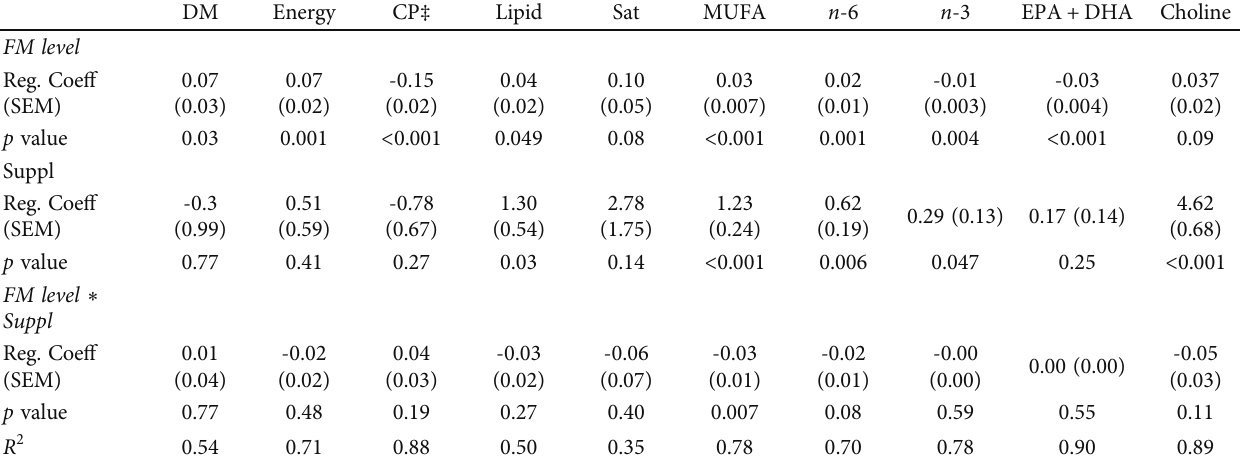
Figure 2: Pyloric intestine somatic index (PISI) and hepatosomatic index (HIS) in fi sh fed two series of diets varying in fi shmeal level, one series without supplements (No suppl) and the other supplemented (Suppl) with a mixture of choline chloride (0.3%), and β -glucan (0.05%) and nucleotides (0.05%). For statistics see Table 3. Table 4: Results of regression analyses of nutrient and energy digestibilities on fi shmeal level based on observations on tank level † . DM